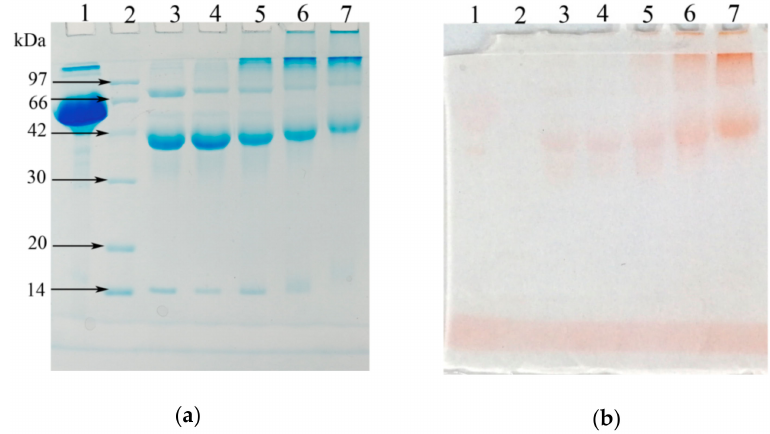
Figure 1. SDS-PAGE profiles of egg white protein (EWP) and isomalto-oligosaccharide (IMO)-EWP conjugates stained for proteins ( a ) or saccharides ( b ). Lane 1: Bovine albumin (negative control); Lane 2: marker proteins; Lane 3: EWP; Lanes 4: EWP incubated at glycation condition for 3 days; Lane 5–7: IMO-EWP conjugates with sugar-protein weight ratios of 2.5%, 10% and 50%, respectively.